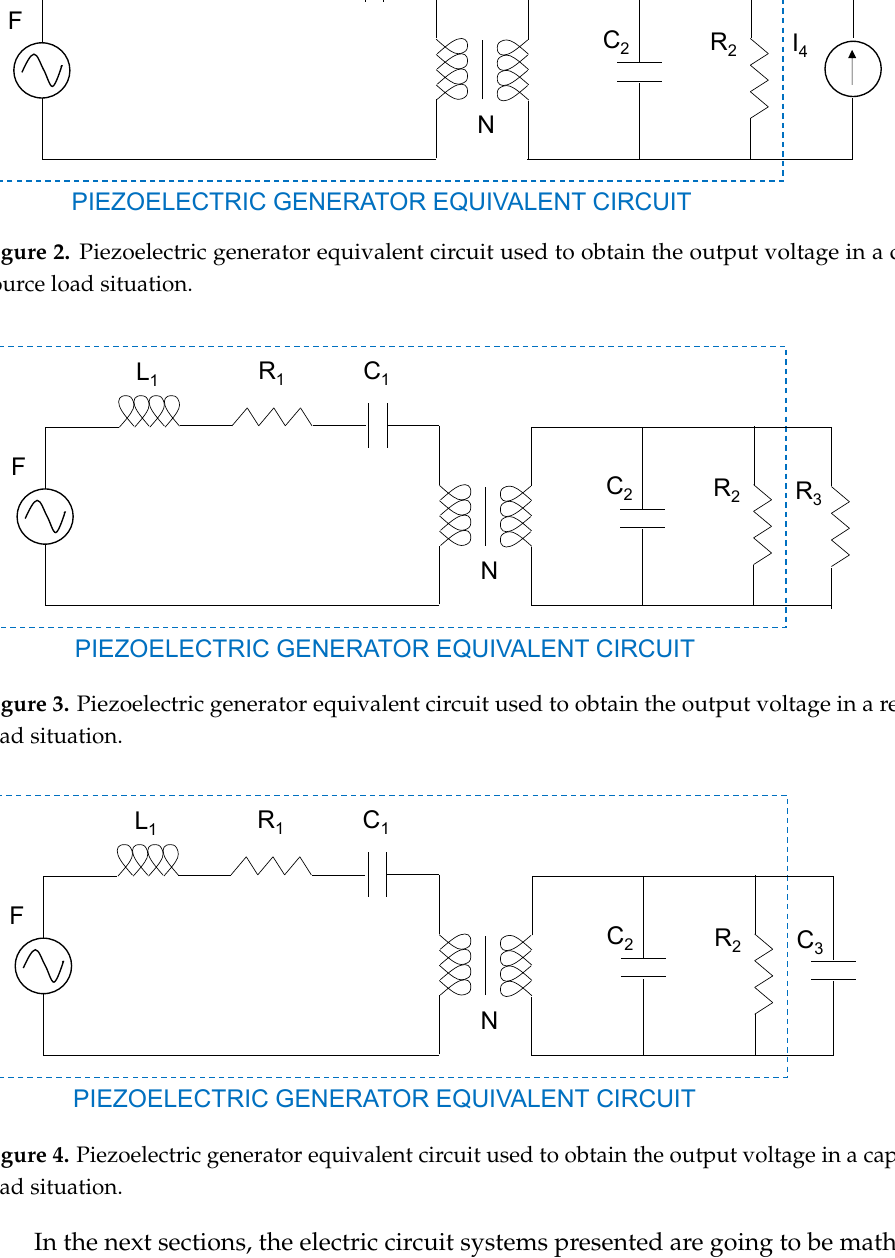
Figure 4. Piezoelectric generator equivalent circuit used to obtain the output voltage in a capacitive load situation.